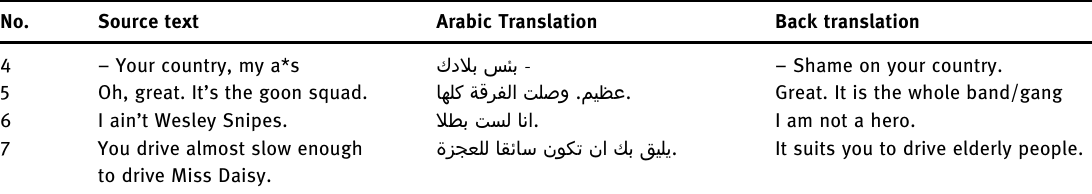
Table 8: Transposition strategy examples